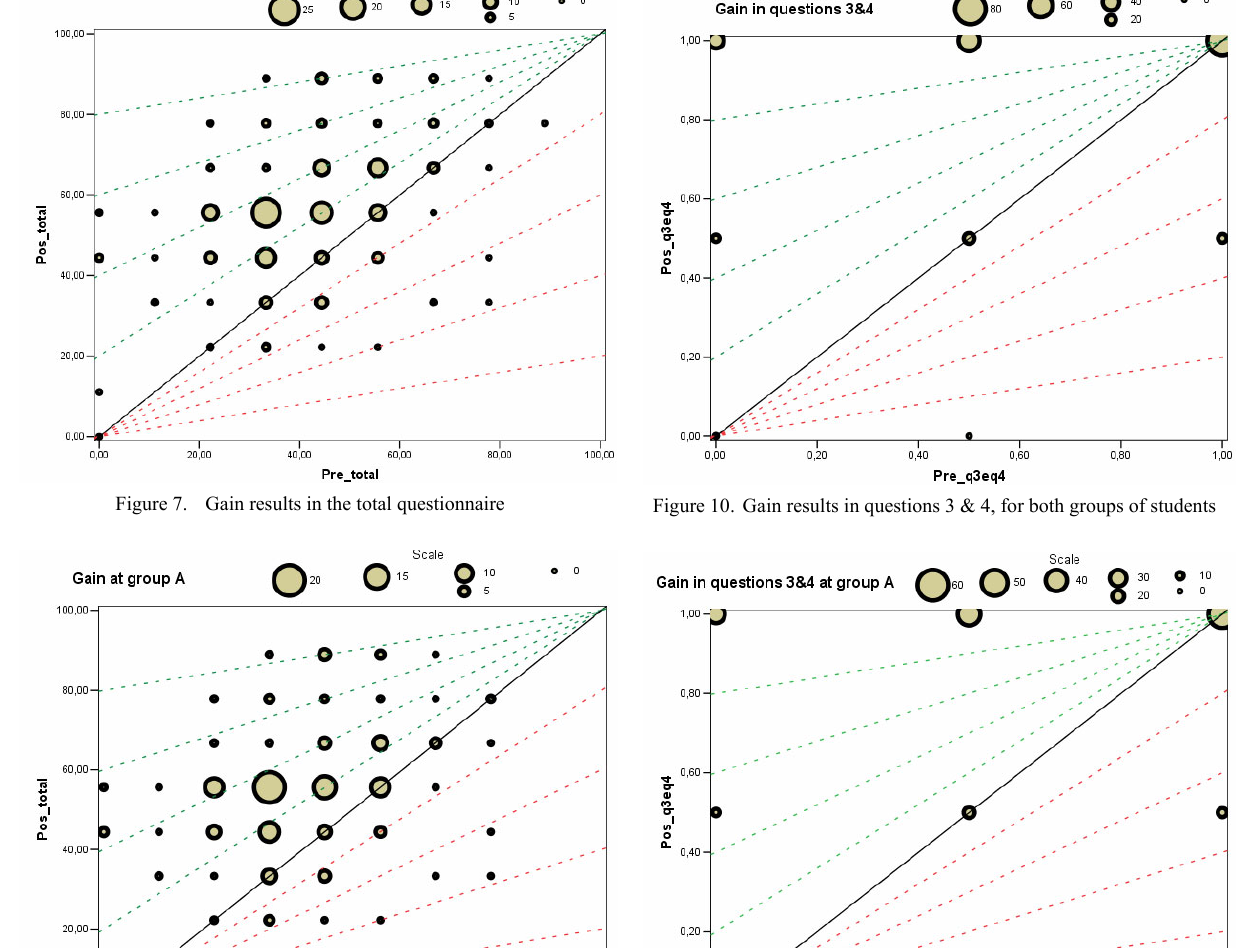
Figure 11. Gain results in questions 3 & 4, for group A students